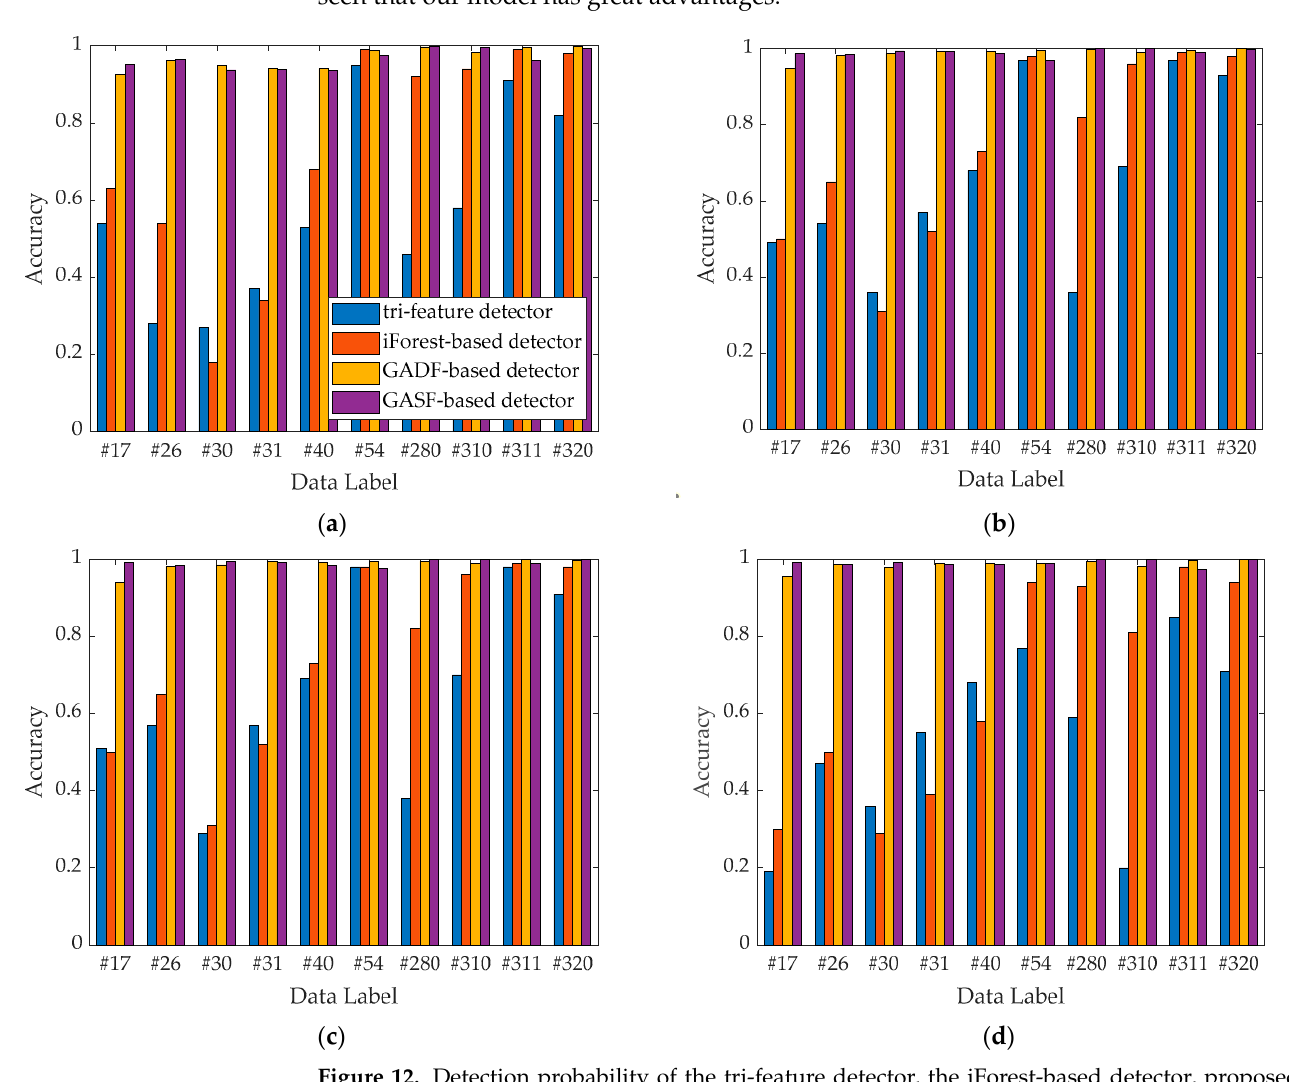
Figure 12. Detection probability of the tri-feature detector, the iForest-based detector, proposed method at ( a ) HH, ( b ) HV, ( c ) VH, and ( d ) VV polarization.